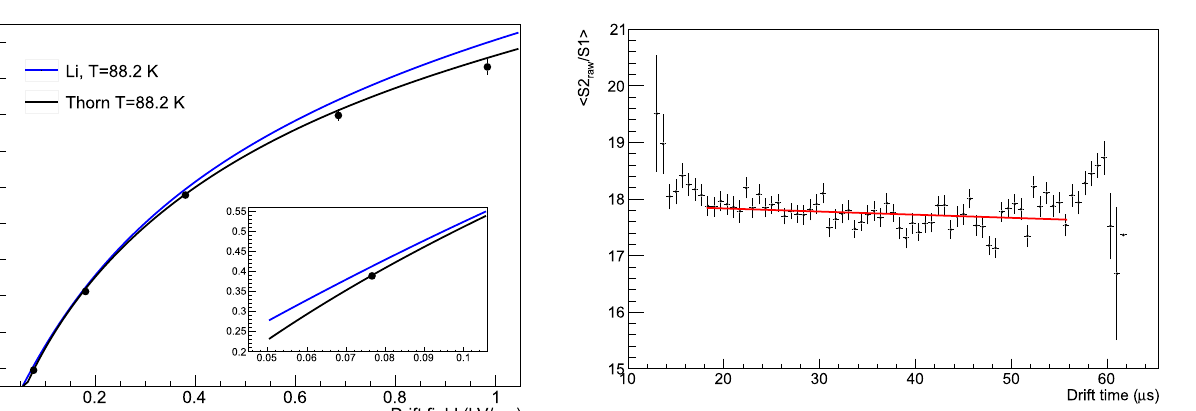
at (cid:5) E ex (cid:6) = ( 3 . 8 ± 0 . 2 ) kV/cm, the transit time through the